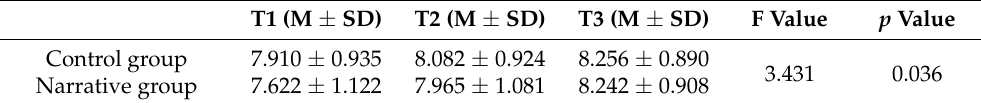
Figure 2. Two-way repeated-measures ANOVA of children’s environmental attitudes. Table 7. Two-way repeated-measures ANOVA of children’s environmental attitudes.